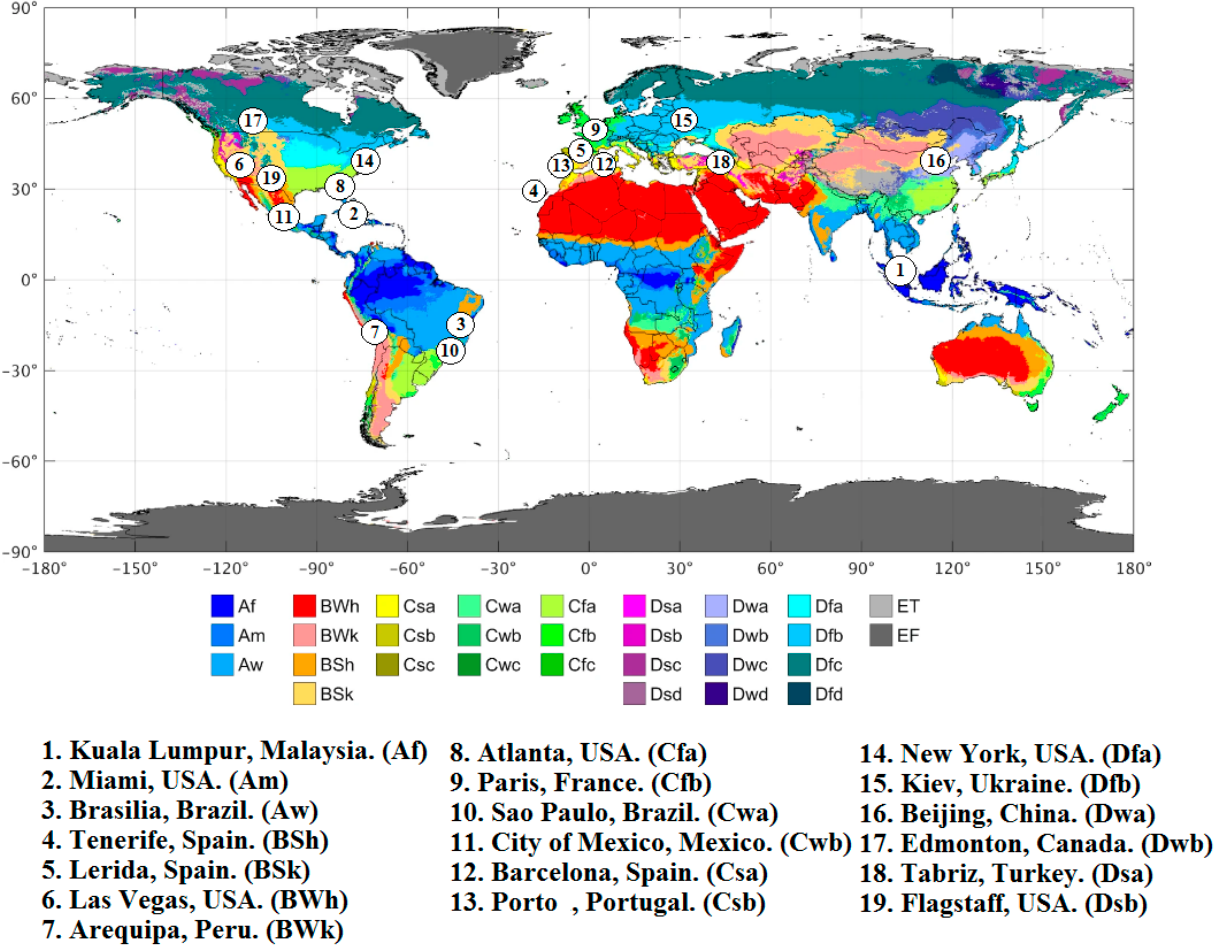
Figure 3. Köppen–Geiger climate classifications (adapted from [28]). Chosen locations are situated and listed.